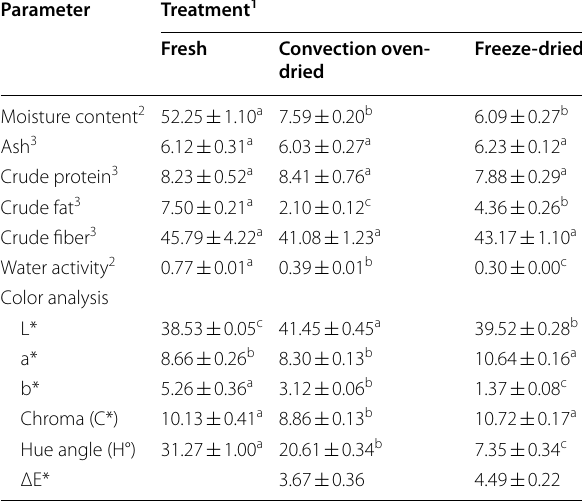
Table 1 Proximate composition and physico‑chemical profile of bignay pomace as affected by drying techniques